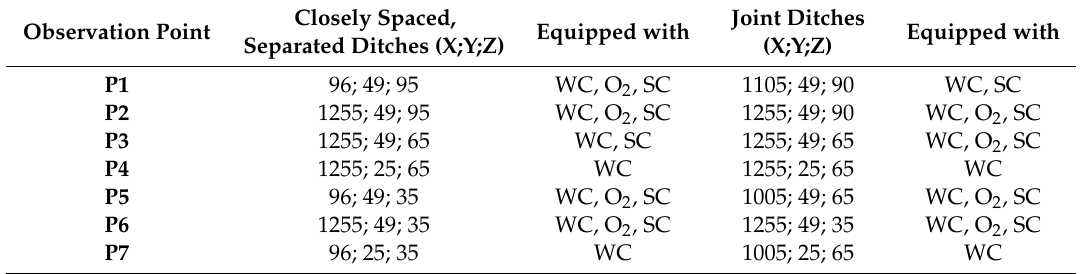
Table 2. Location of observation points for both set-ups using a local coordinate system having point of origin (0;0;0) at the lower left corner of the tank, WC is water content, O 2 is oxygen, SC is suction cup. Observation Point